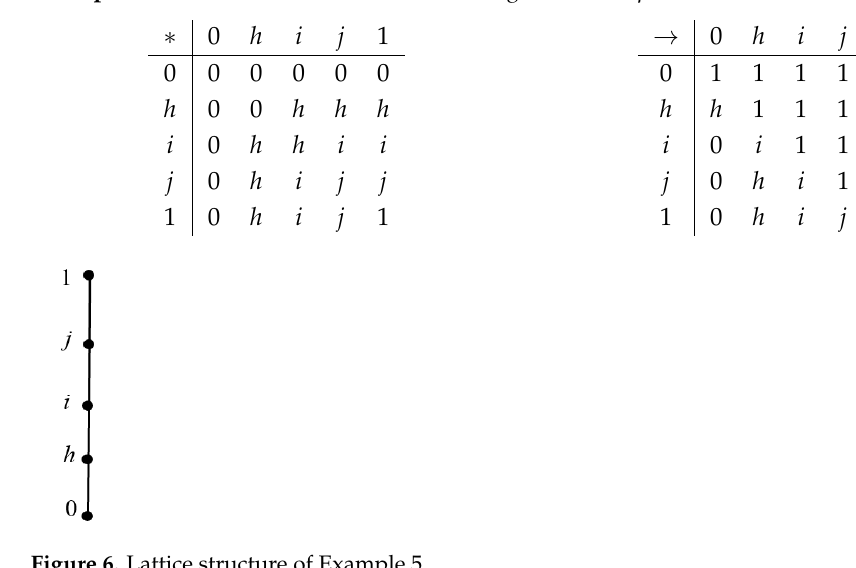
Figure 6. Lattice structure of Example